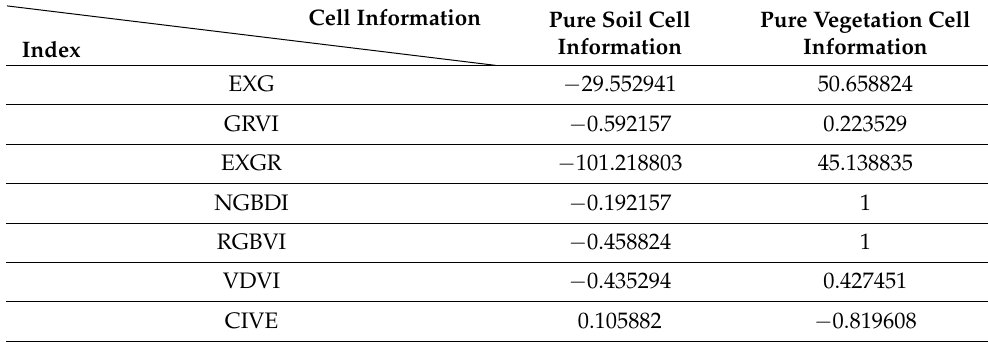
Table 3. Figure category pixel count in